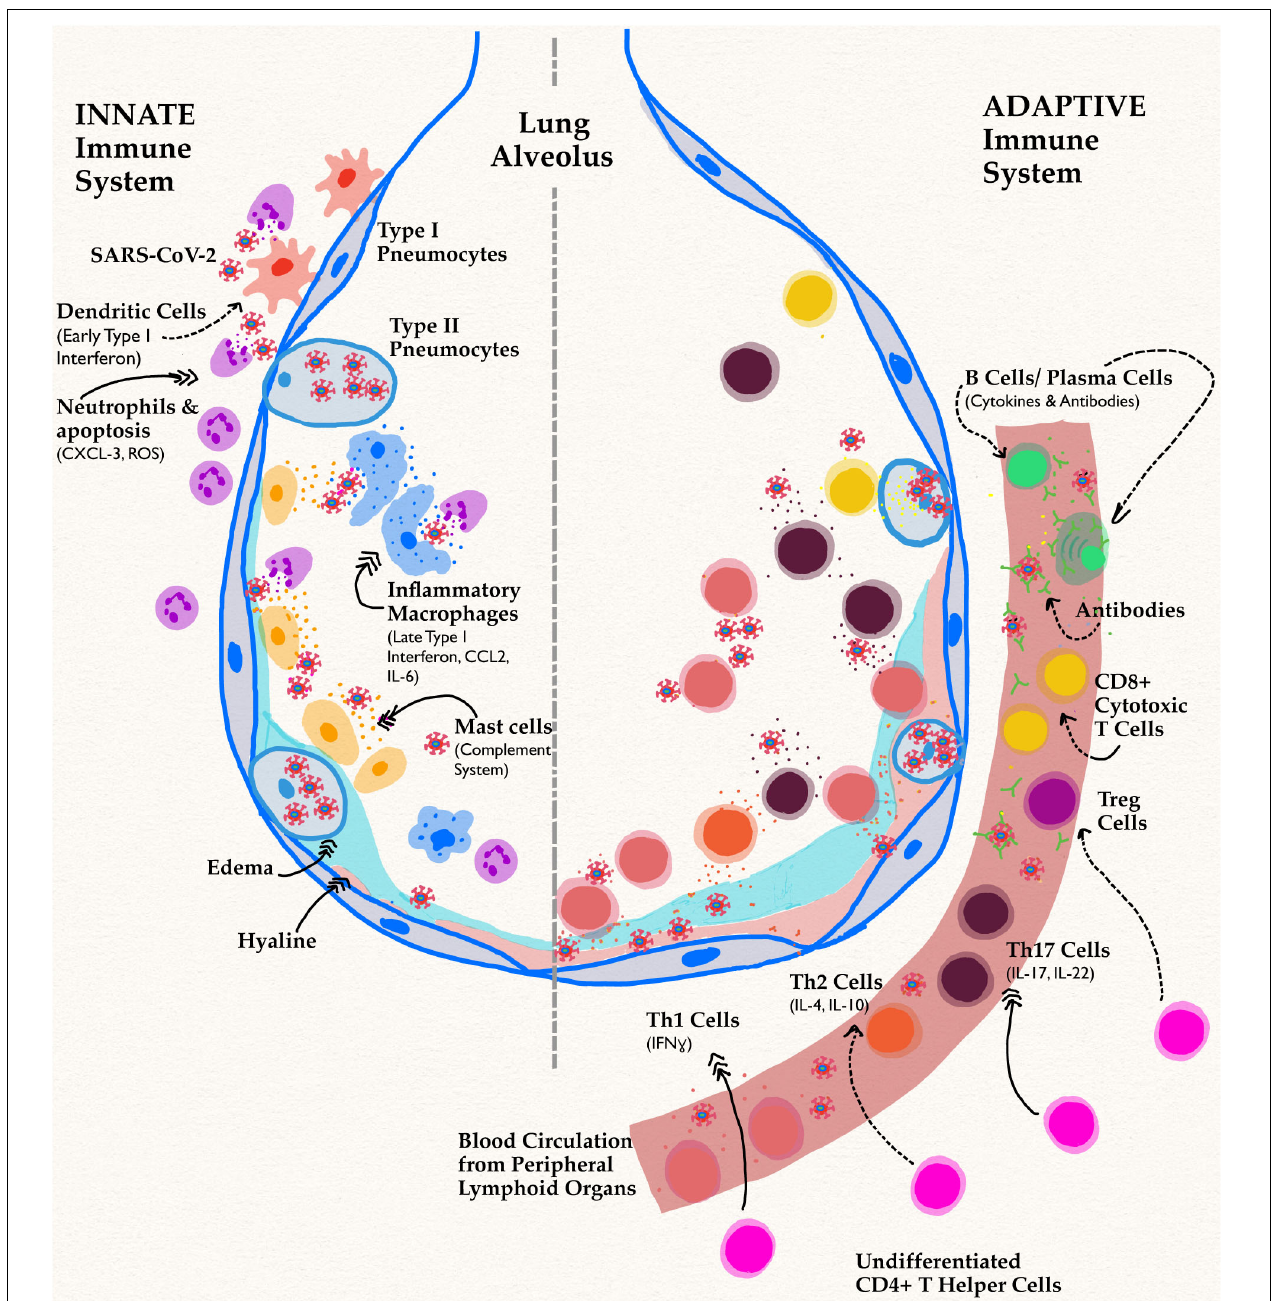
FIGURE 2 | Innate and adaptive immune responses in SARS-CoV-2 Infection. Schematic shows a lung alveolus and a blood vessel. The left side of the figure describes effects of the innate immune system specifically in men, while the right side depicts their delayed adaptive immune functions. Dotted arrows represent a decrease in function or activity, while triple headed solid arrows signify an increase compared to infection in women. The most implicated cell types and their associated cytokines have been shown. In men, the novel coronavirus infection has reduced activation of APC and early proinflammatory processes. A decrease in this pathway causes delayed, excessive proinflammatory cytokine responses leading to the infamous cytokine storm implicated in both components of